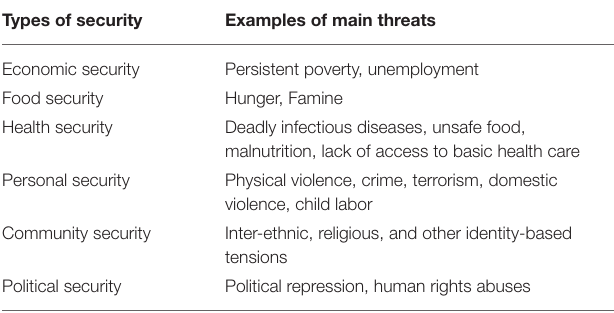
TABLE 1 | Possible types of human security